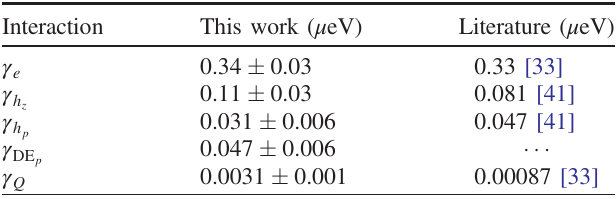
TABLE I. The various interaction energies as obtained by the best model fitting to the measured temporal depolarization of five different electronic spin qubits confined in the same QD. The theoretical model and the fitted parameters are described in the text and the